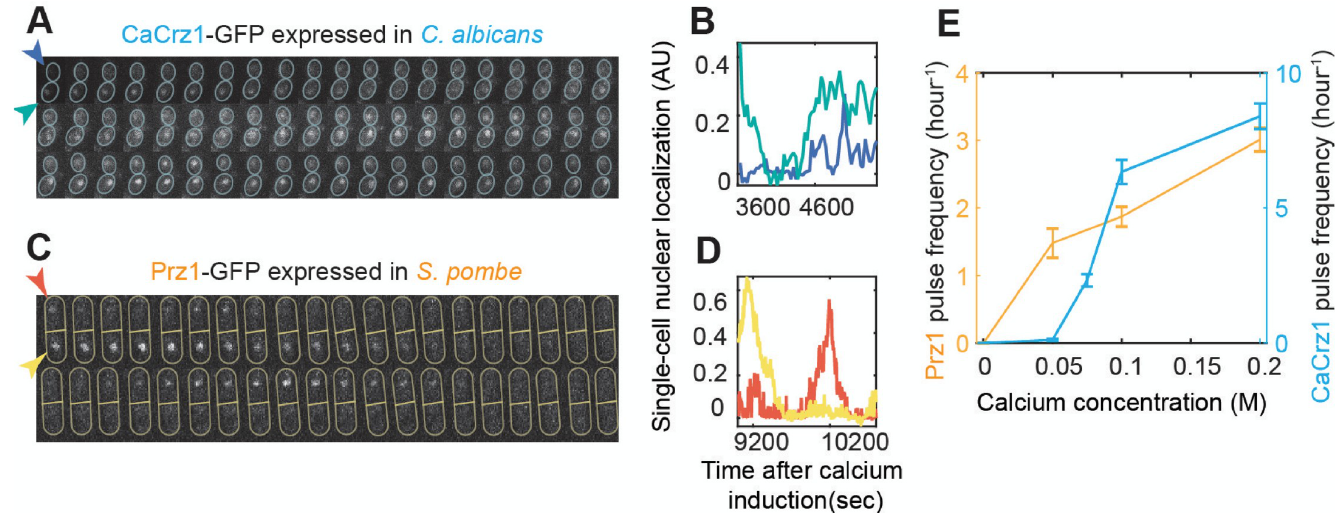
Fig 3. C . albicans and S . pombe show pulsing and frequency modulation. Filmstrips are showing C . albicans (A) and S . pombe (C) with GFP-tagged Crz1 orthologues (CaCrz1 and Prz1, respectively) during steady state after the addition of 0.2 M extracellular calcium. Yeast cells are outlined in each frame and indicated through the arrows in the first frame, which are colored accordingly to the single-cell trajectories in B) and D). A) Frames are separated by 30 seconds, and the actual time resolution in B) is the same. C) Frames are separated by 45 seconds, but the actual time resolution in D) is 6 seconds per frame. Image acquisitions of each species were performed through different microscopes. E) Populational average of pulse frequency increases with calcium concentration for both Crz1 orthologues. Error bars represent 1.96 SE. n > 30 in each experiment. AU: Arbitrary Units.